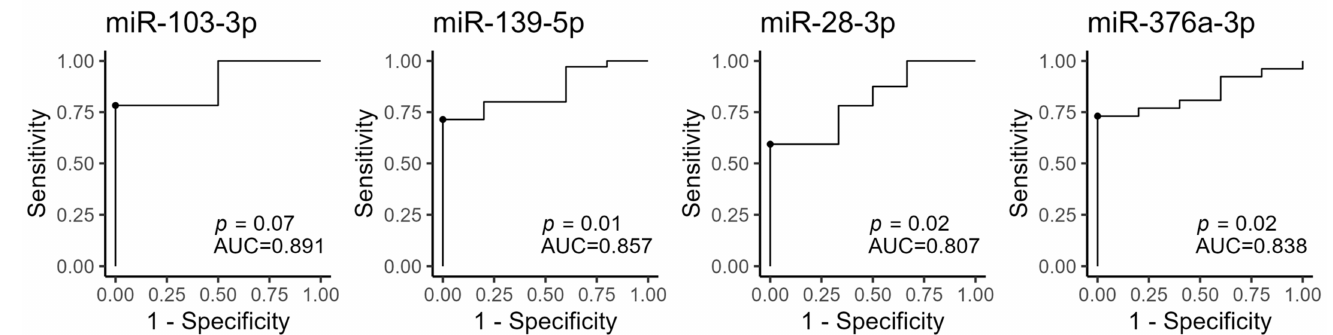
Figure 3. ROC curves of the four miRNAs measured at BL. The optimal cut-off point (Youden index) is marked with a black circle. AUC: Area under the curve. miR-103-3p: n = 25; miR-139-5p: n = 40; miR-28-3p: n = 38, miR-376a-3p: n = 31.